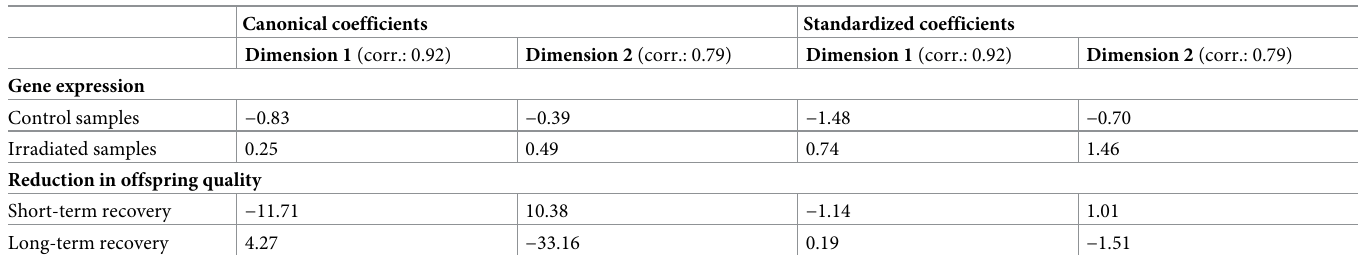
Table 3. Canonical correlation coefficients.